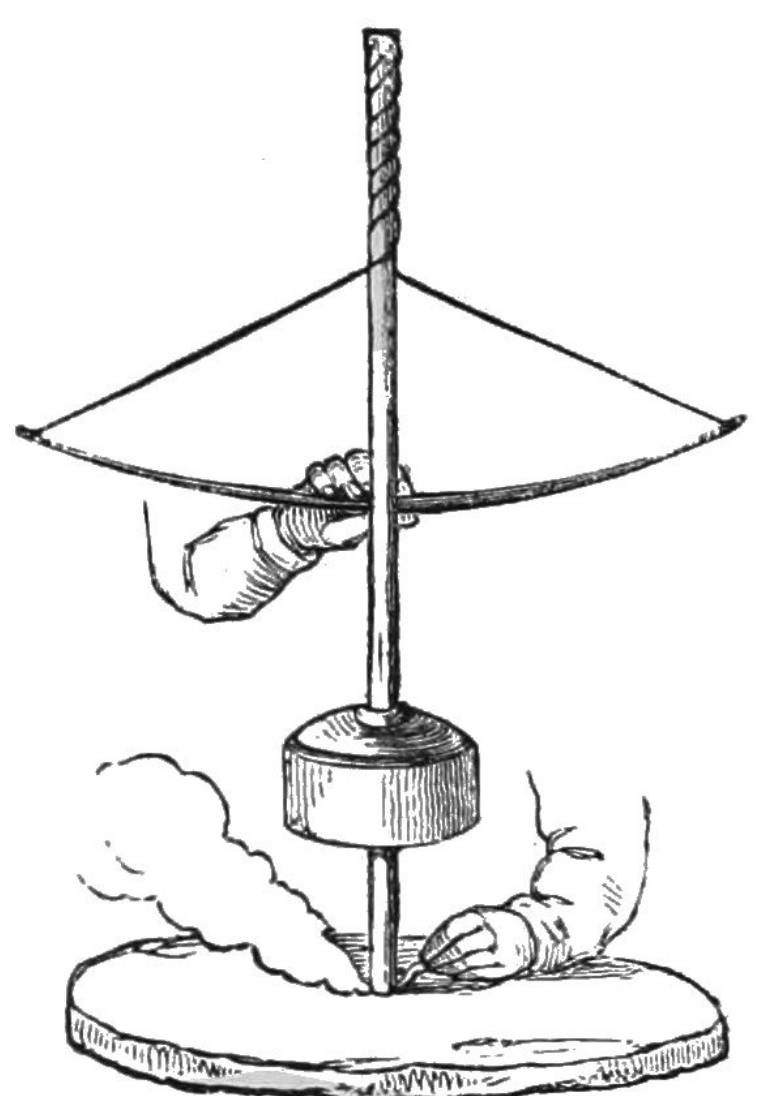
Figure 4. Pump drill components (after Joly 1877: fig.7).